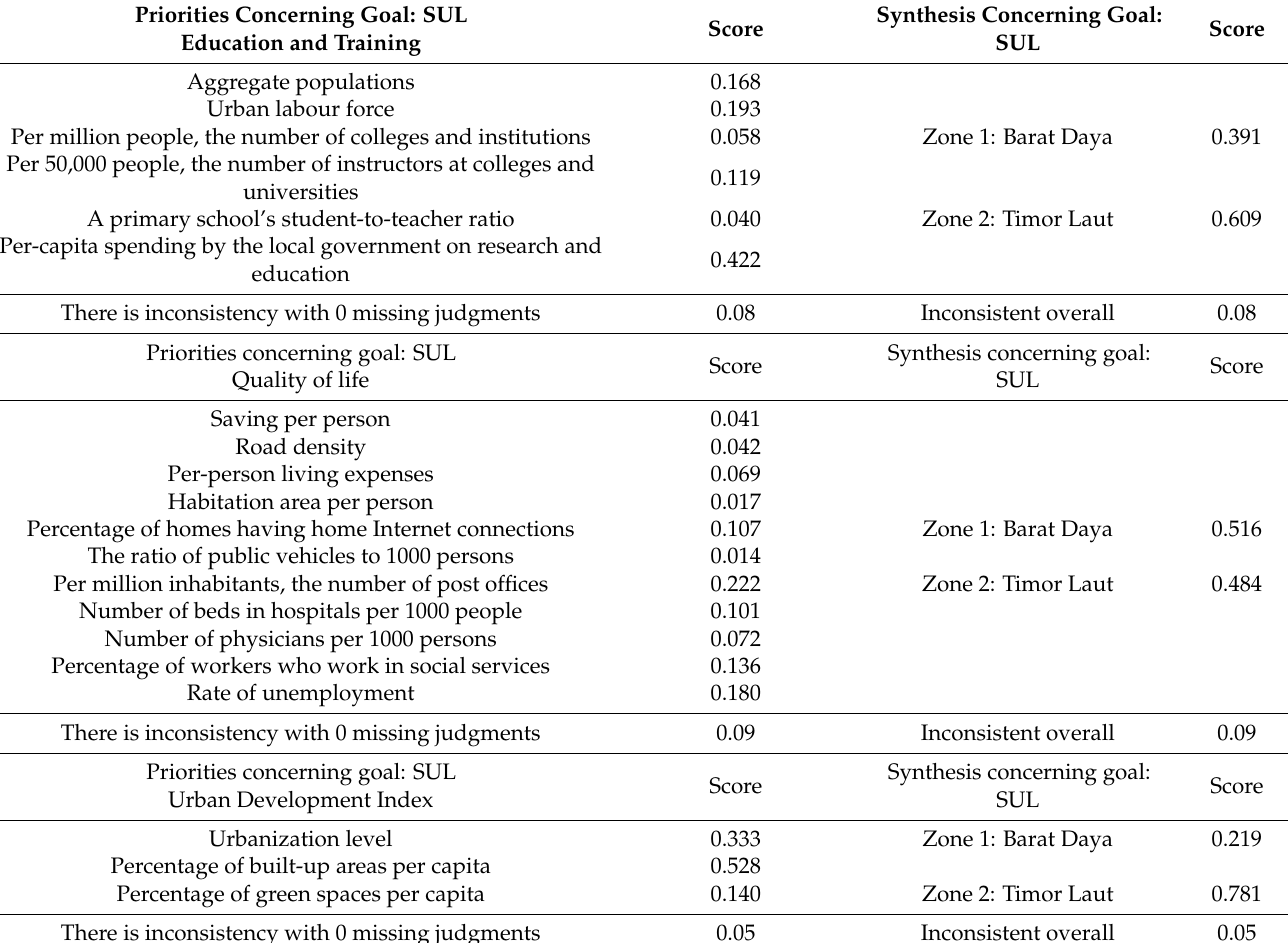
Table 7. Final weights for the urban landscape’s sociocultural criterion, sub-criteria, and